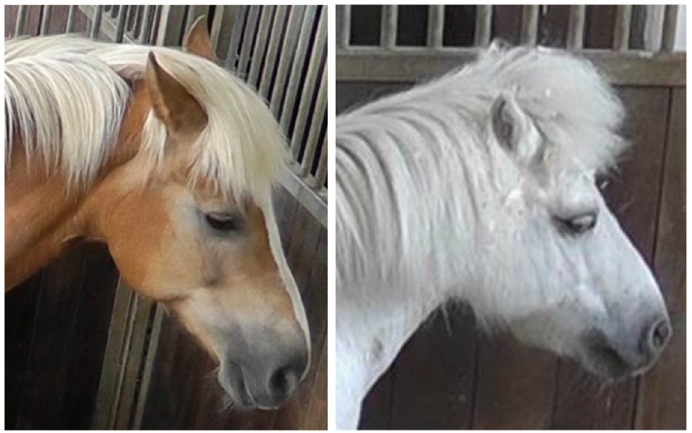
Figure 1. Example of pictures scored by the students.